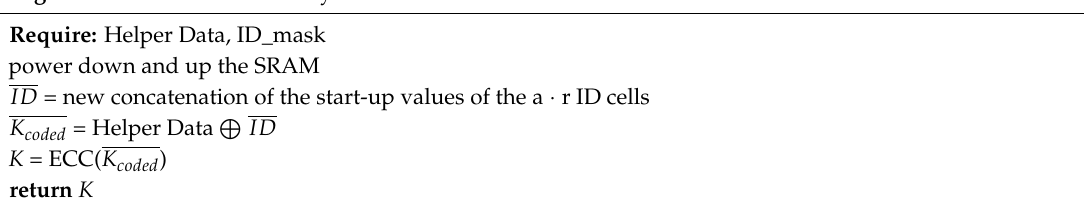
Algorithm 4 Pseudo-code of key